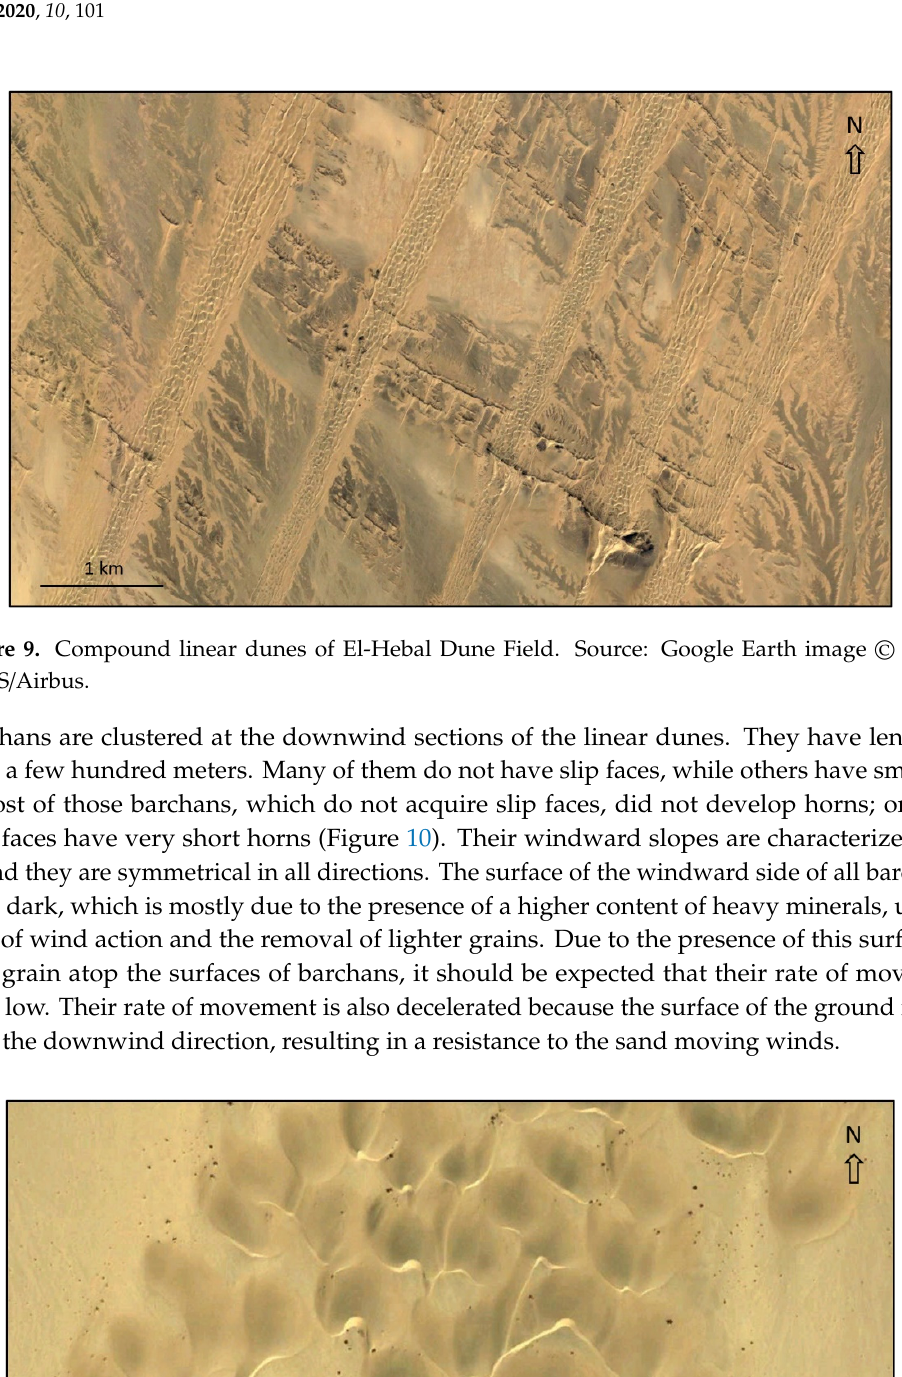
Figure 10. Barchans of El-Hebal Dunes. Source: Google Earth image © 2019 CNES/Airbus.